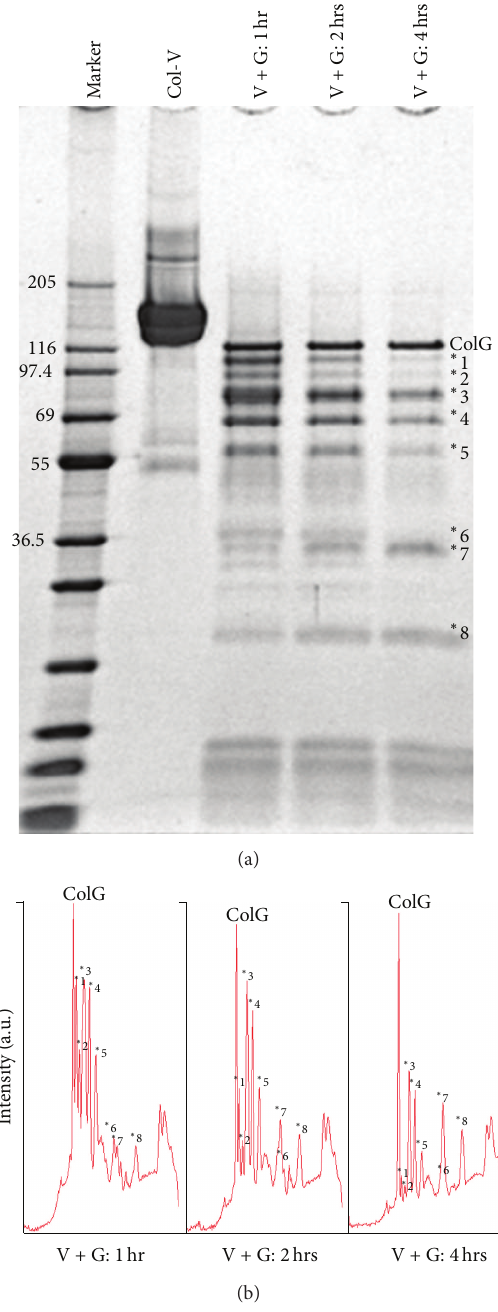
Figure 4: SDS-PAGE analysis of Col-V digestion by ColG over a long time period ( ∼ 4h). (a) SDS-PAGE analysis of Col-V digestions. ColG and the main bands are numbered. (b) Band intensity analysis by